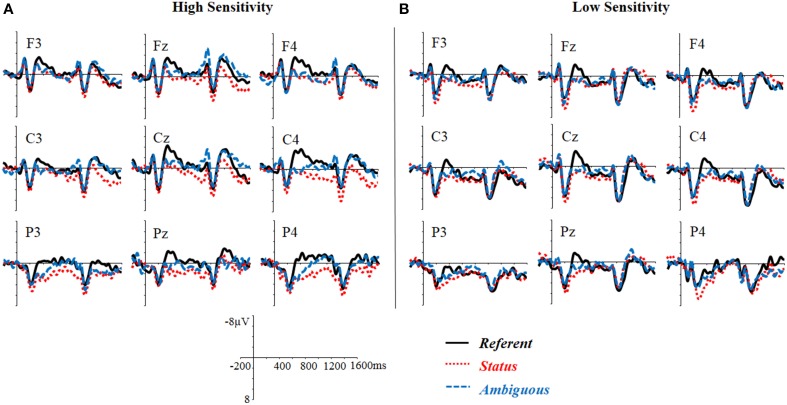
Grand average waveforms time locked to the pronoun on 9 representative electrodes for the three critical conditions in the high-status-sensitivity (A) and the low-status-sensitivity (B) individuals. The high- and the low-sensitivity individuals were defined according to the median split of the differential score (DS) in the appropriateness rating between the status-congruent and the status-incongruent condition (Median = 3.98). Those with the DS lower than 3.98 were defined as low-sensitivity individuals (n = 16, Mean = 2.71, ranging from 0 to 3.90) while those with DS higher than 3.98 were defined as high-sensitivity individuals (n = 16, Mean = 4.72, ranging from 4.05 to 5.95).